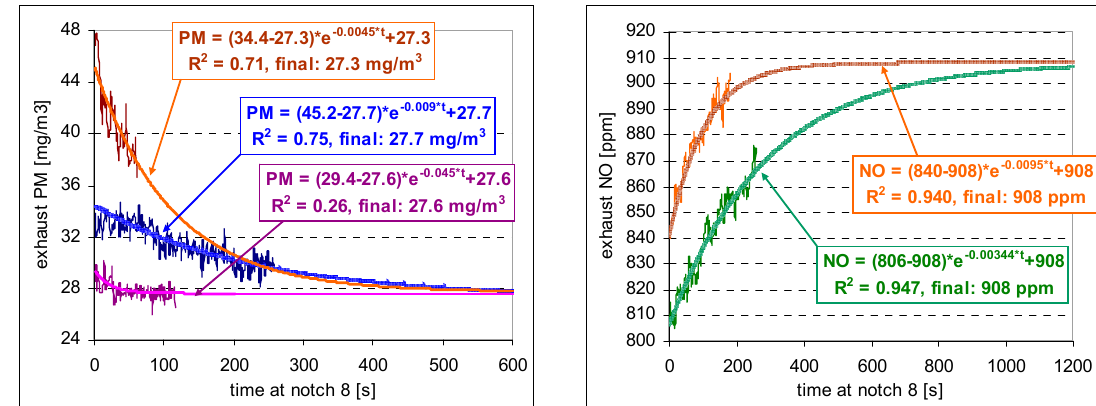
Figure 11. Estimate of steady-state notch 8 concentrations of PM ( left ) and NO ( right ) by extrapolation (described in [45]) of measured data.